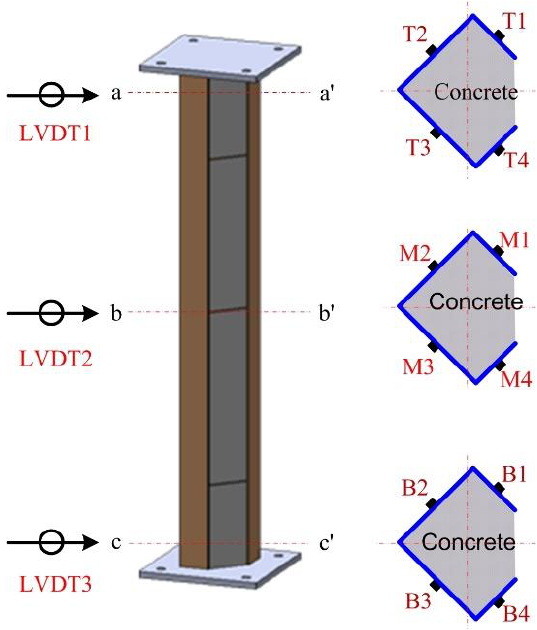
Figure 6. Data acquisition location.